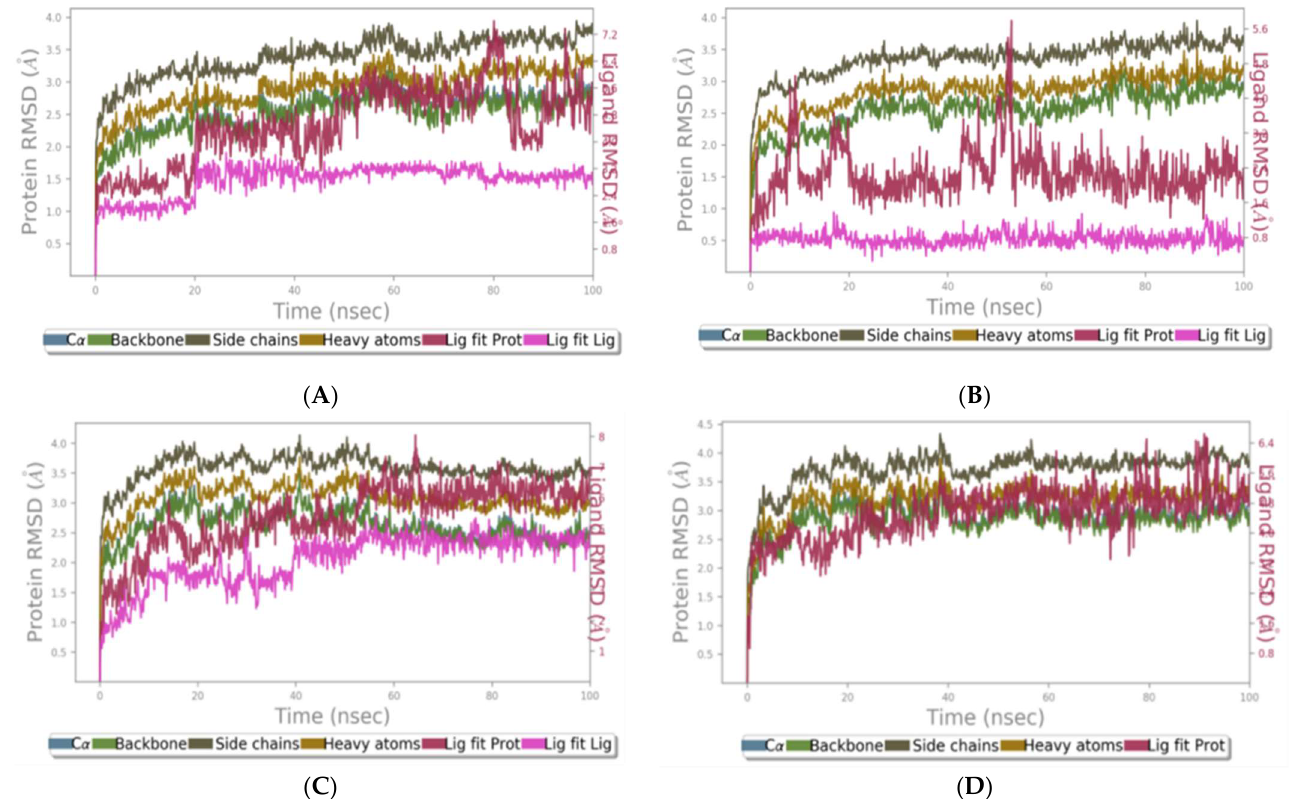
Figure 5. RMSD analysis of 100 ns MD simulation trajectory. The RMSD plots for clade A/E- ( A ) NP-005114, ( B ) NP-007382, ( C ) NP-007422, and ( D ) NP-008297 complexes. ( A ) NP-005114, ( B ) NP-007382, ( C ) NP-007422, and ( D ) NP-008297